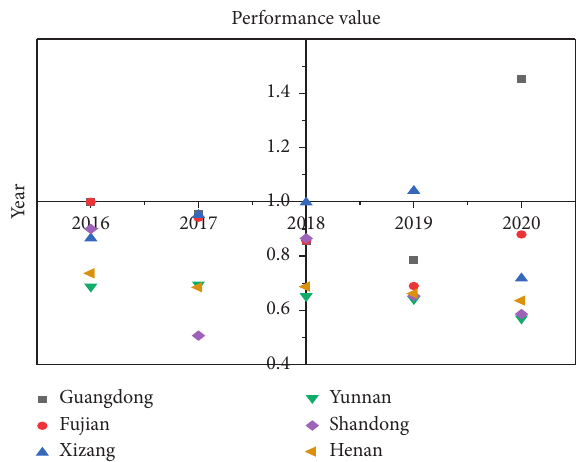
Figure 2: Comparison of performance evaluation values of employee pension insurance in multiple provinces.